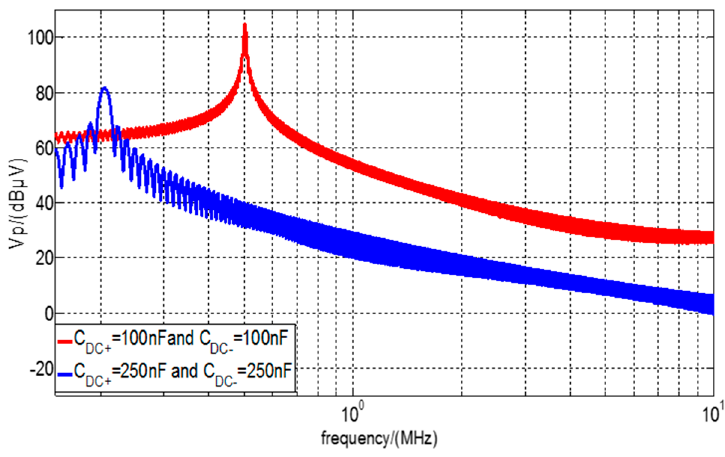
Figure 16. Positive CE voltage after C DC+ and C DC − were increased.